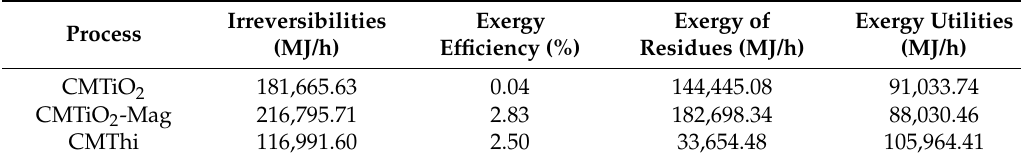
Table 6. Results for exergy performance of each processing